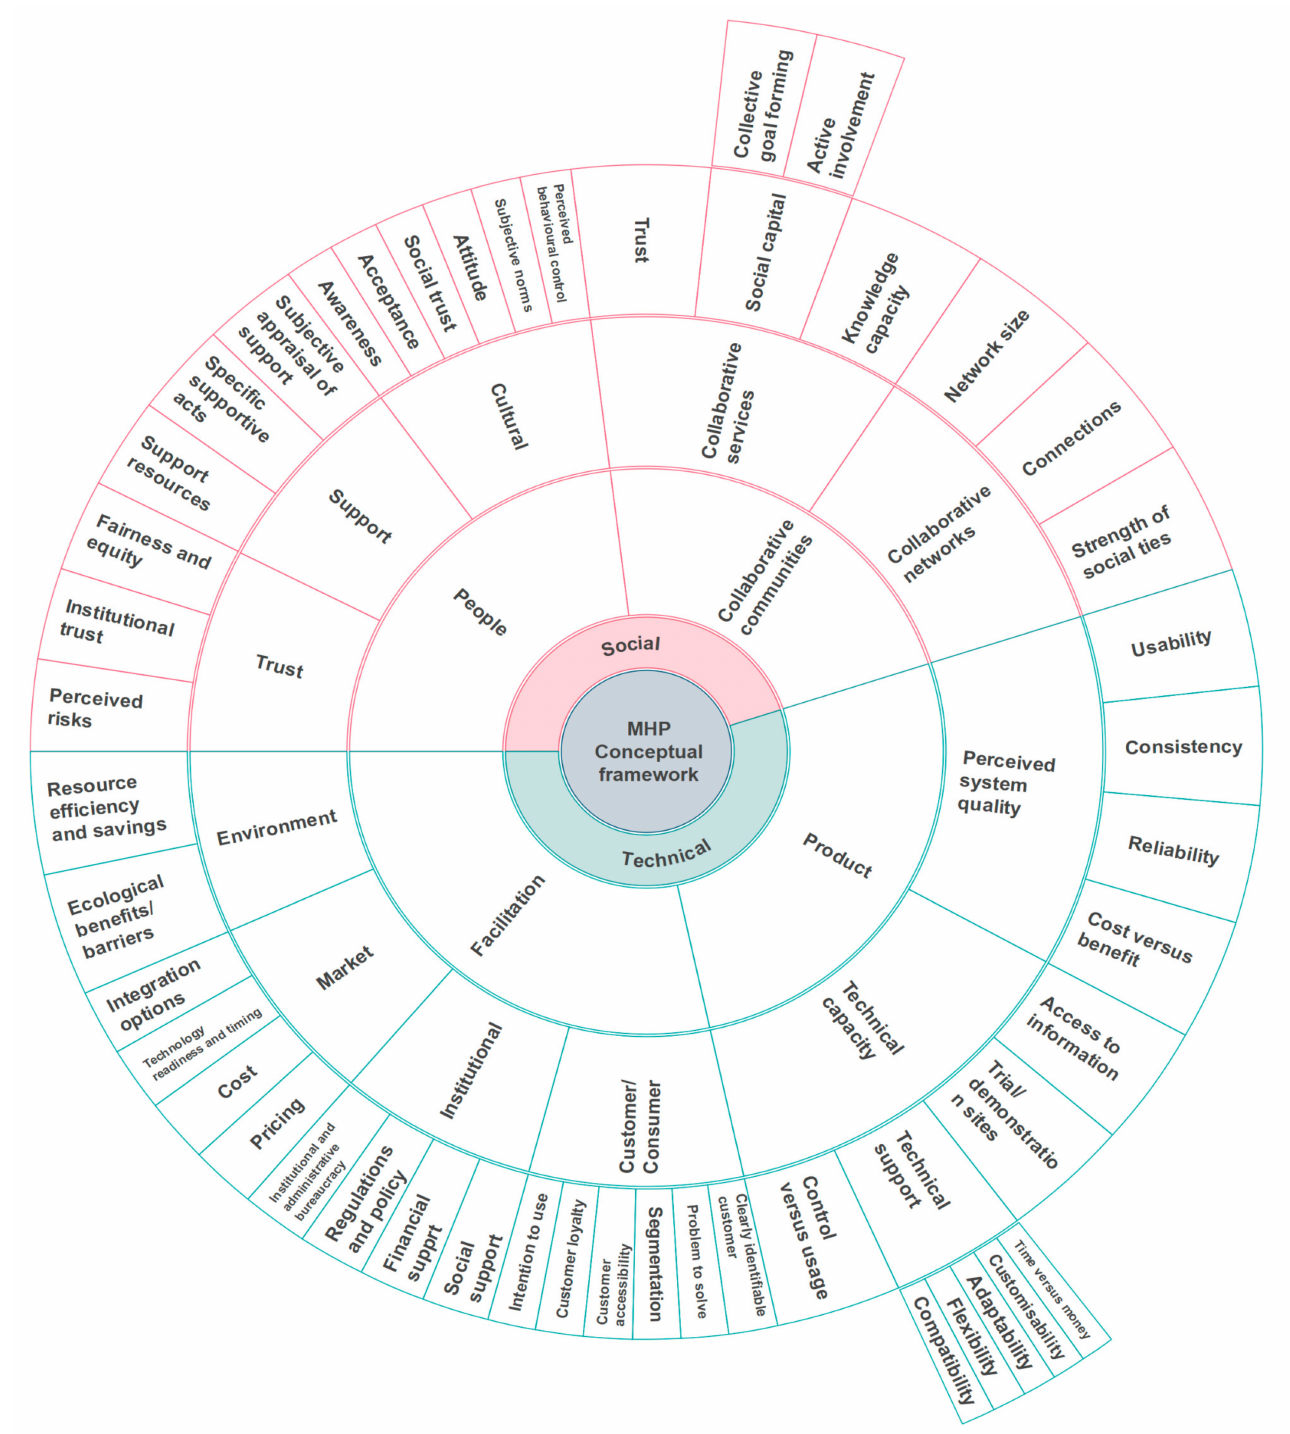
Figure 4. Conceptual framework for MHP